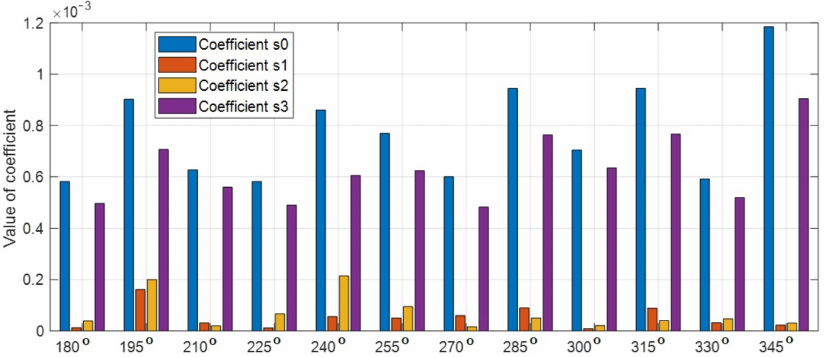
Figure A1. Linear coefficient data S = [ s 0 , s 1 , s 2 , s 3 ] T for truck: profile angle changes from 0 ◦ to 165 ◦ (periodicity 15 ◦ ).